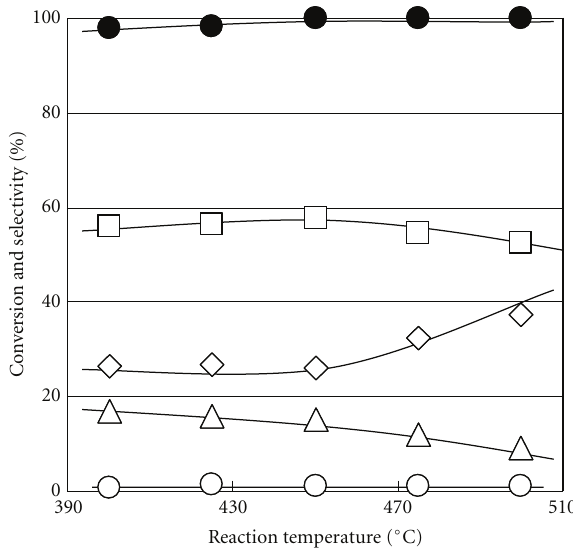
Figure 1: Conversion and product selectivity of catalytic cracking